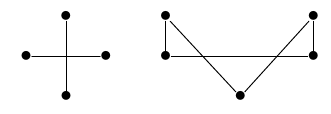
Figure 1. Two topologically inconsistent